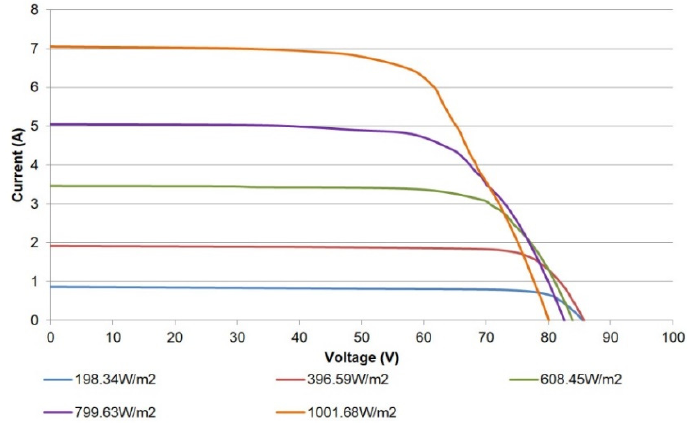
Figure 18. I ‐ V curves for two PV modules connected in series. Figure 18. I-V curves for two PV modules connected in